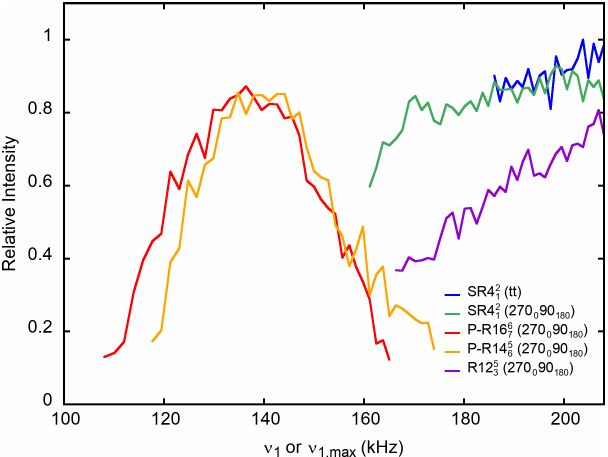
Figure 7. The 27 AlO 6 on-resonance signal of γ -alumina at ν R = 62 . 5kHz as a function of ν 1 or ν 1 , max for PRESTO- R16 6 (270 0 90 180 ) and PRESTO-R14 5 (270 0 90 180 ) as well as 7 6 RINEPT-CWc-SR4 2 (tt), RINEPT-SR4 2 (270 0 90 180 ) and RINEPT- 1 1 R12 5 (270 0 90 180 ). For each curve, τ was fixed to its optimum value 3 given in Table 3. Figure 6. The 27 Al 1D spectra of AlPO 4 -14 at 18.8T with ν R = 20kHz (a) and 62.5kHz (b) acquired using 1 H → 27 Al transfers with RINEPT-CWc and SR4 2 (tt), SR4 2 (270 0 90 180 ) 1 1 and R12 5 (270 0 90 180 ), or PRESTO and (a) R22 7 (180 0 ) and 3 2 R18 5 (180 0 ), or (b) R16 6 (270 0 90 180 ) and R14 5 (270 0 90 180 ). The 7 2 6 τ delays and ν 1 /ν 1 , max rf fields were fixed to their optimal values given in Tables 2 and 4. The resonance at ca. 11ppm in panel (a) is due to an impurity.